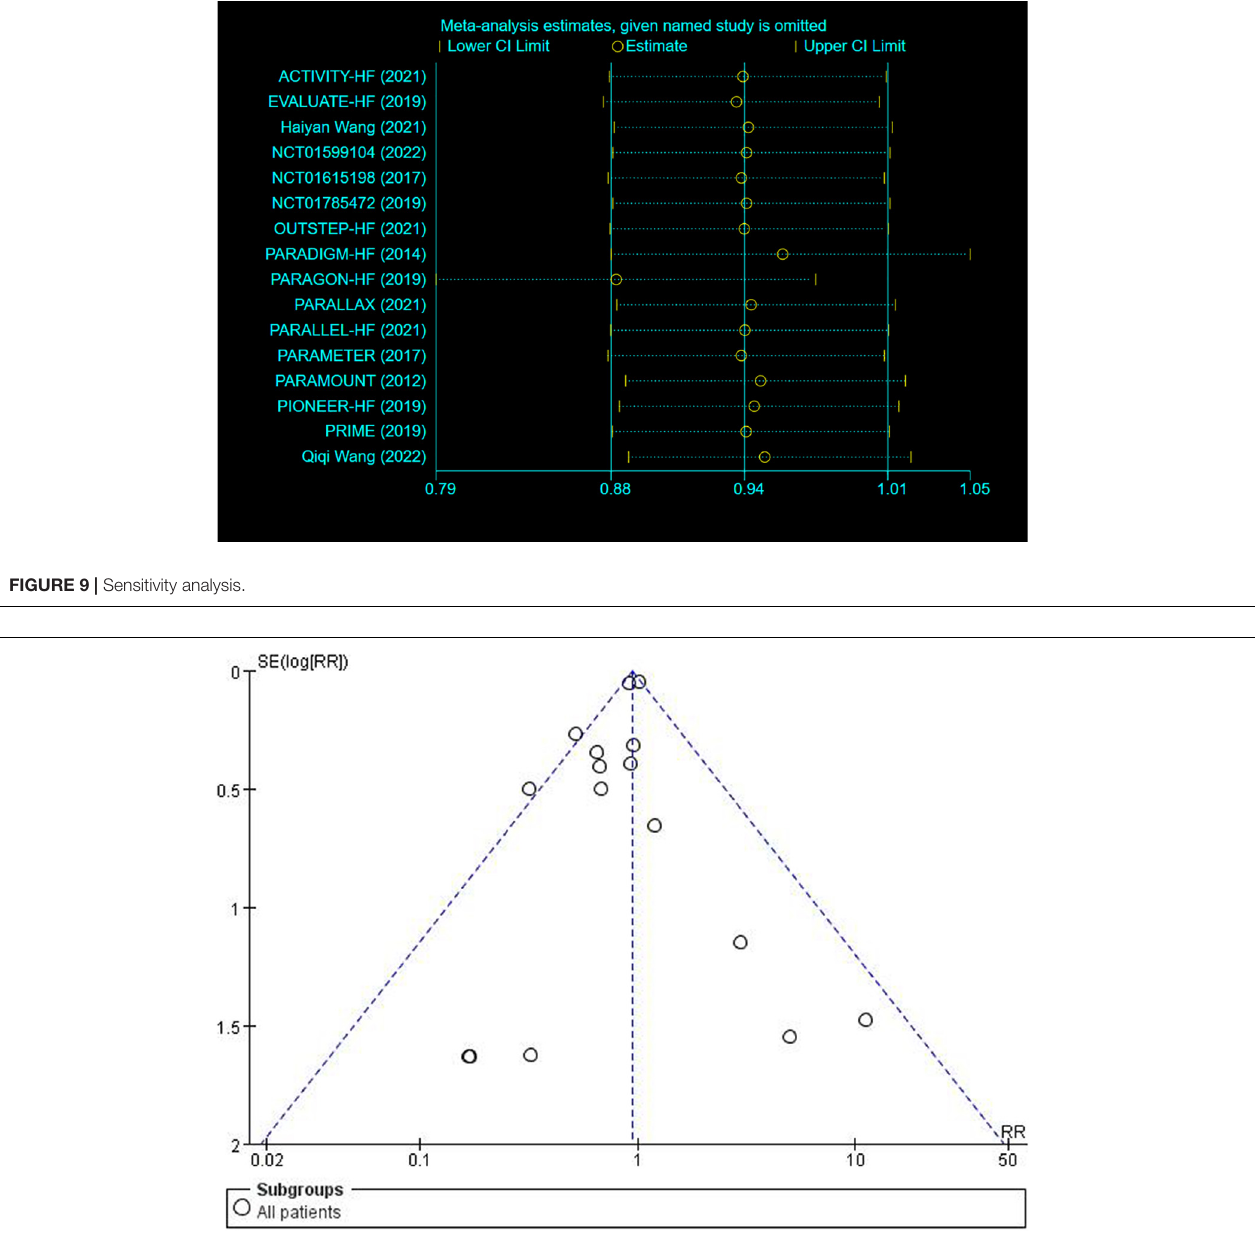
FIGURE 10 | Funnel